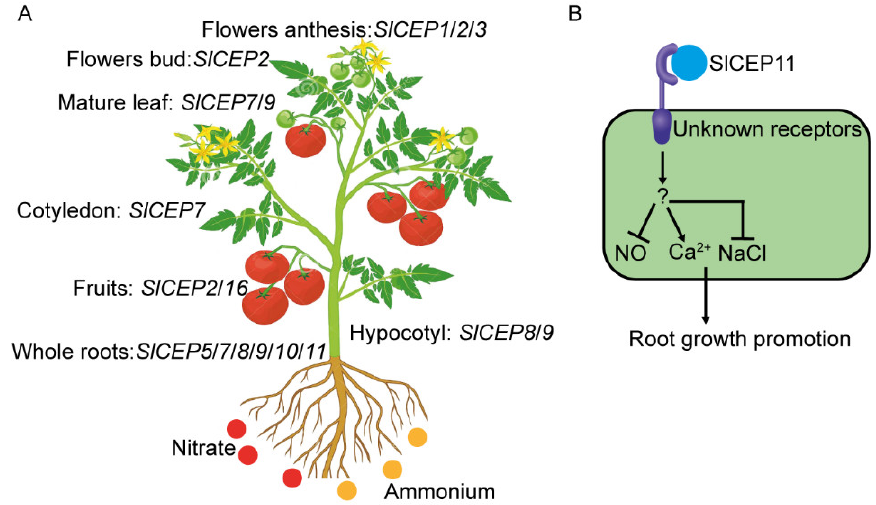
Figure 7. Summary of our work. ( A ) Expression pattern of SlCEP s in tomato tissues based on the public RNA-seq data. SlCEP s were also differentially regulated by nitrate and ammonium in roots and shoots, respectively. ( B ) A proposed working module for SlCEP11 peptide in tomato root development. SlCEP11 was perceived by unknown receptors, then regulated an undefined player to modulate NO, Ca 2+ and salinity signaling, ultimately leading to root growth